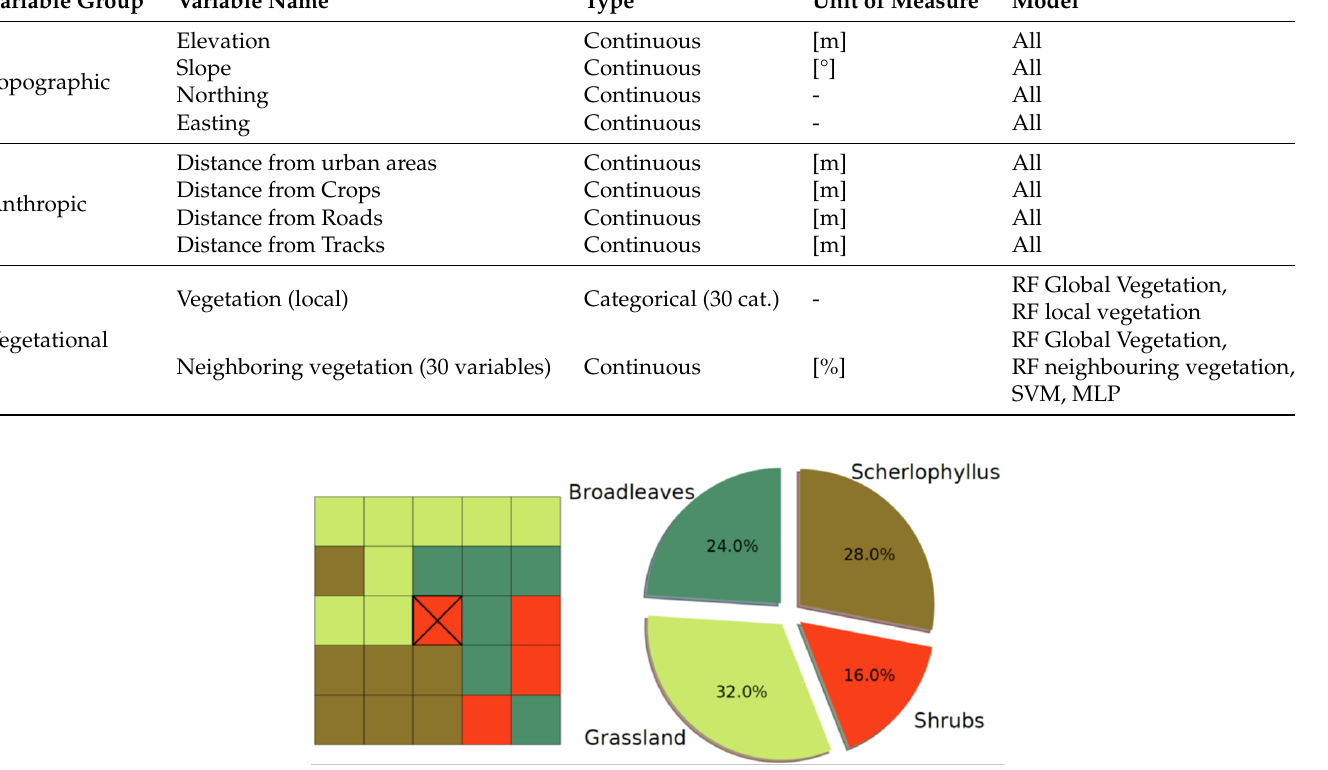
Figure 4. Neighboring vegetation variables—computational